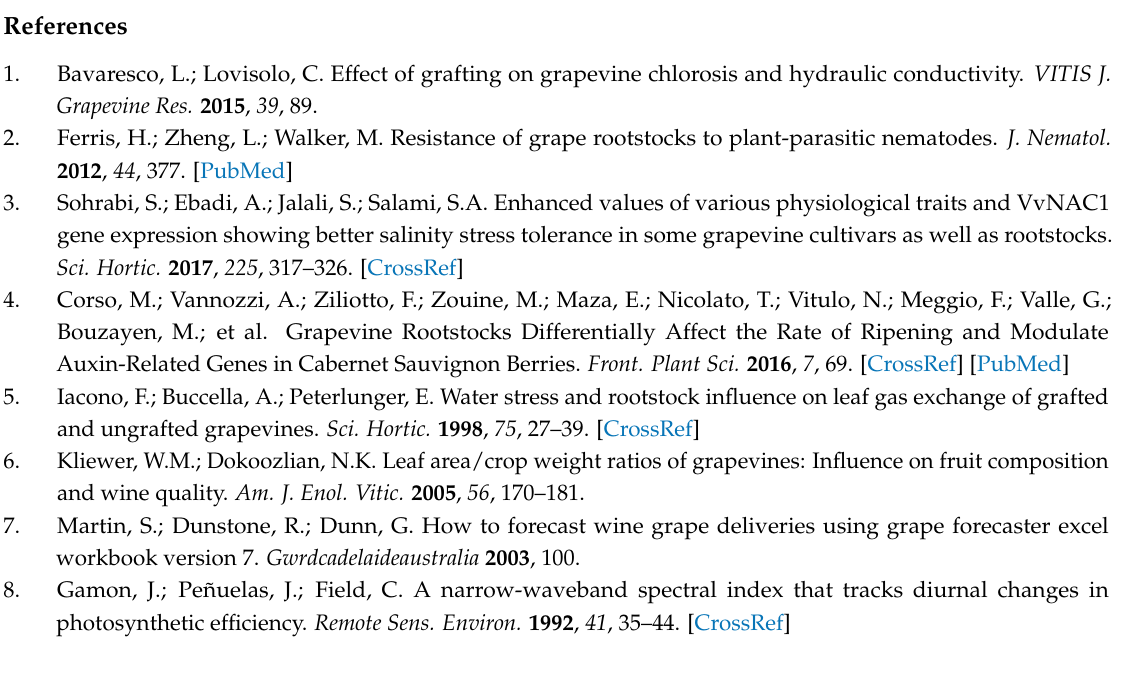
Table S1: Mean R 2 ± standard deviation of model runs with 10 repetitions, Tables S2–S5: Tukey’s test and ANOVA results of different data